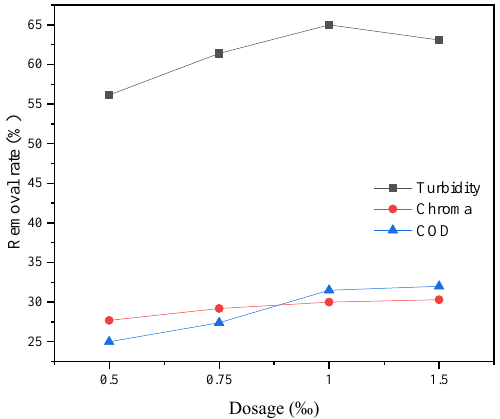
Figure 3. Effect of PAC addition on the flocculation results.